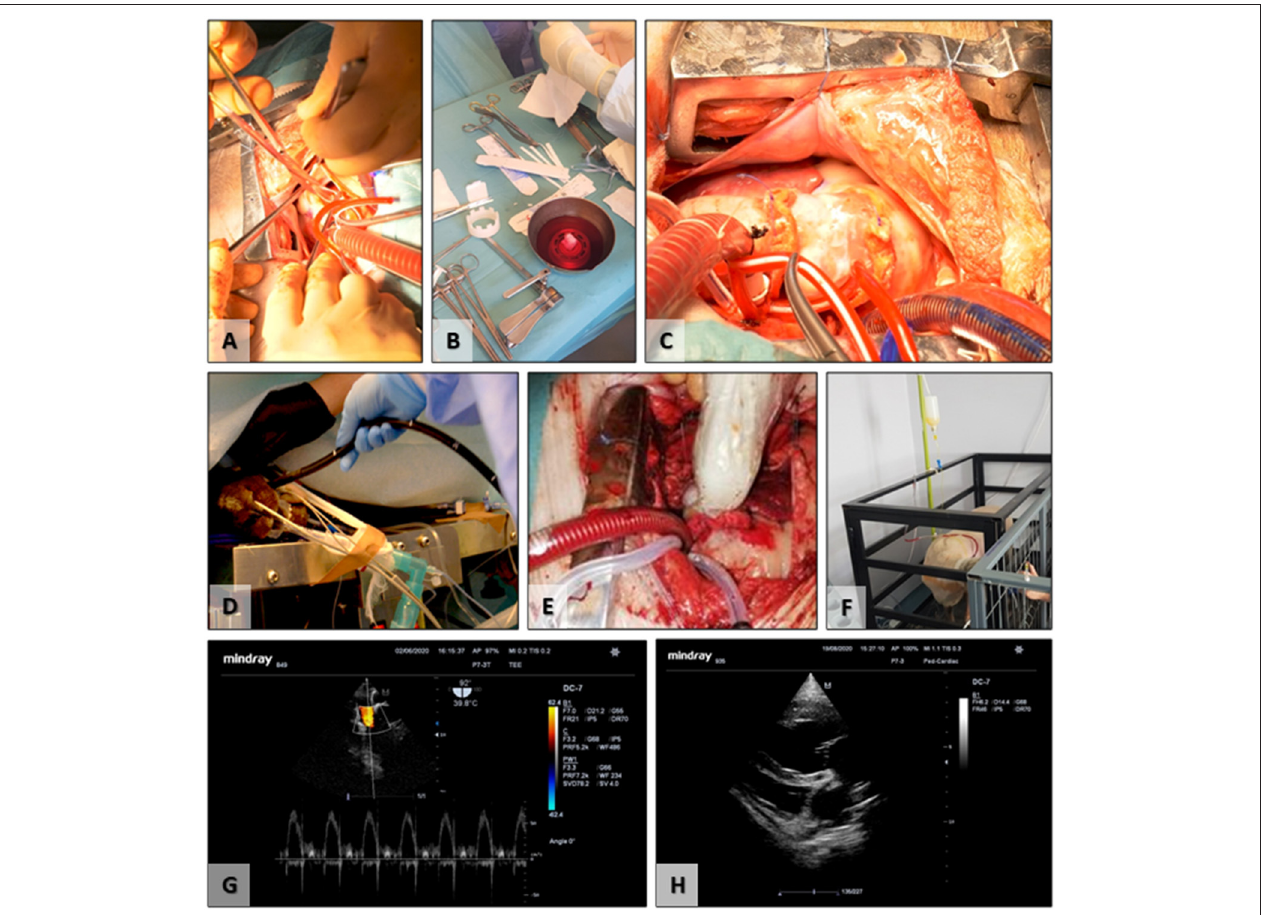
FIGURE 5 | Surgical implantation and follow-up. (A) Removal of the native pulmonary valve; (B) preparation of the TEHV before implantation; (C) final surgical aspect, postimplantation; (D) insertion of the transesophageal ultrasound probe; (E) intraoperative epicardial ultrasound; (F) postoperative experimental animal transthoracic ultrasound; (G) transesophageal ultrasound evaluation of the TEHV; (H) postoperative transthoracic evaluation of the cardiac cavities and